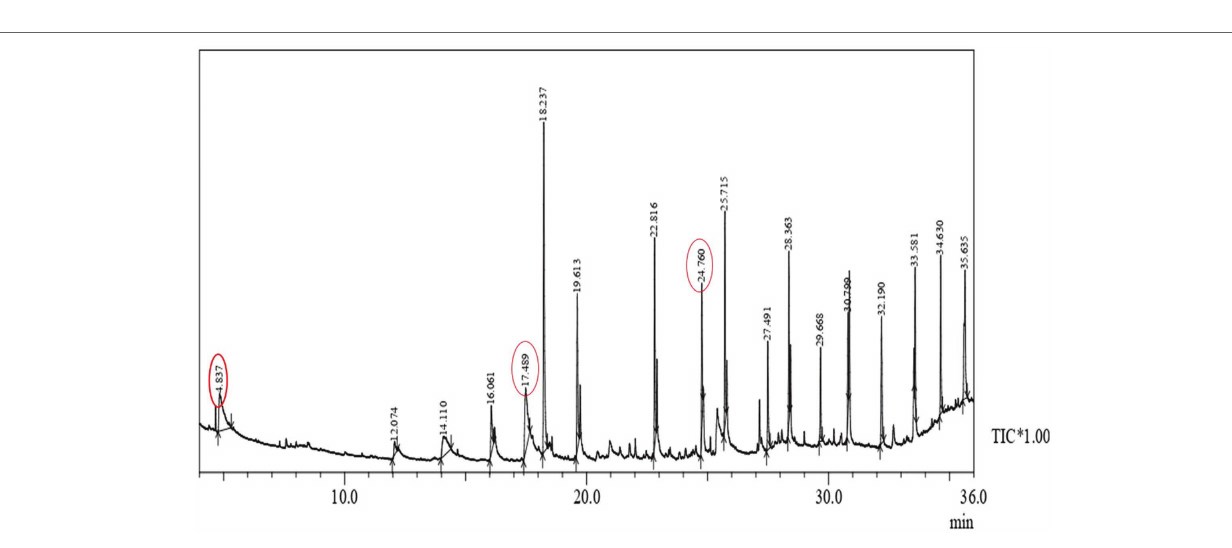
FIGURE 9 | Gas chromatography-mass spectrometry (GC-MS) of extracted polymer from P. aeruginosa